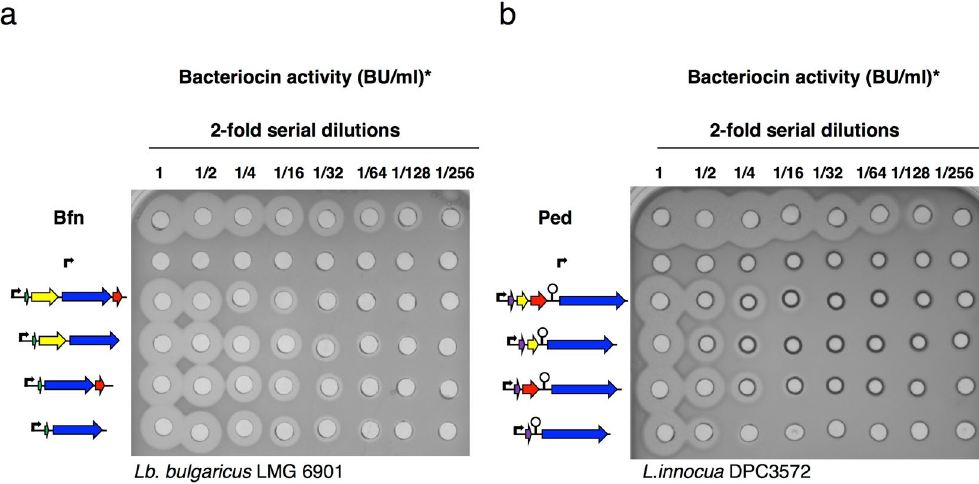
Figure 4. Relative quantification of cell-free supernatants (Bacteriocin units (BU)/ml). Antimicrobial activity of ( a ) bactofencin A and ( b ) pediocin PA-1 produced by E . coli transformed with the plasmids APC2313 (control), APC2315, APC2318, APC2321 and APC2322, and APC2658, APC2663, APC2664 and APC2666, respectively, in comparison with the samples from the natural producers Lb . salivarius DPC6502 (Bfn) and P . acidilactici LMG2351 (Ped). * Bacteriocin activity (BU/ml) was calculated as the inverse of the highest dilution showing inhibition of indicator strains divided by volume (0.05